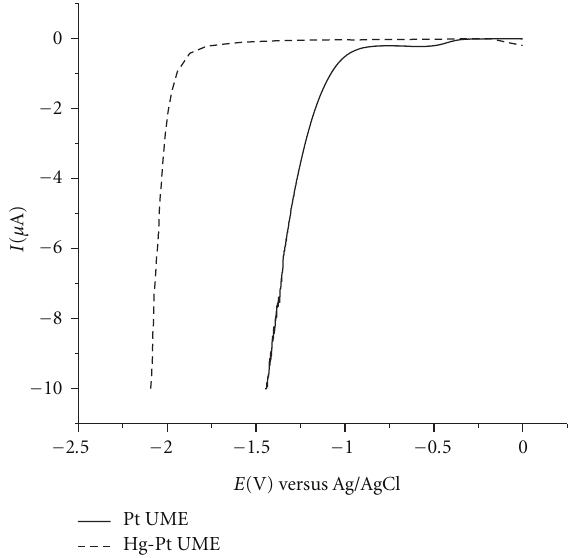
Figure 2: Current-potential curves for Pt and Hg-Pt UMEs in 0.1molL − 1 KNO 3 .